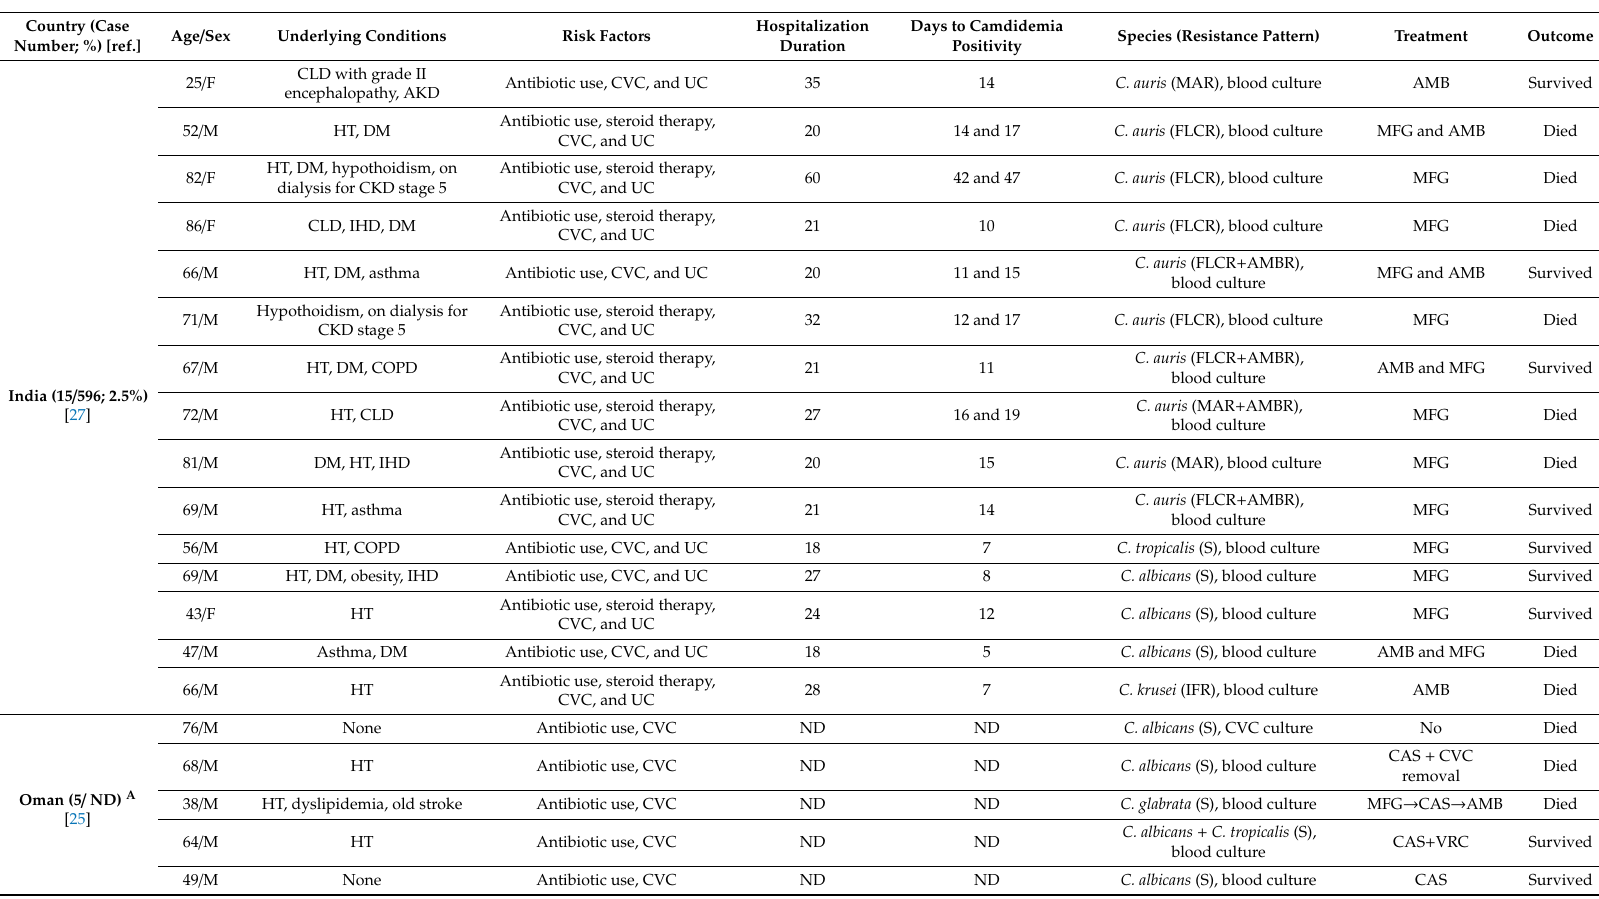
Table 1. Clinical and microbiological features of COVID-19-associated invasive yeast infections in studies with detailed clinical and microbiological data. Country (Case Number; %)